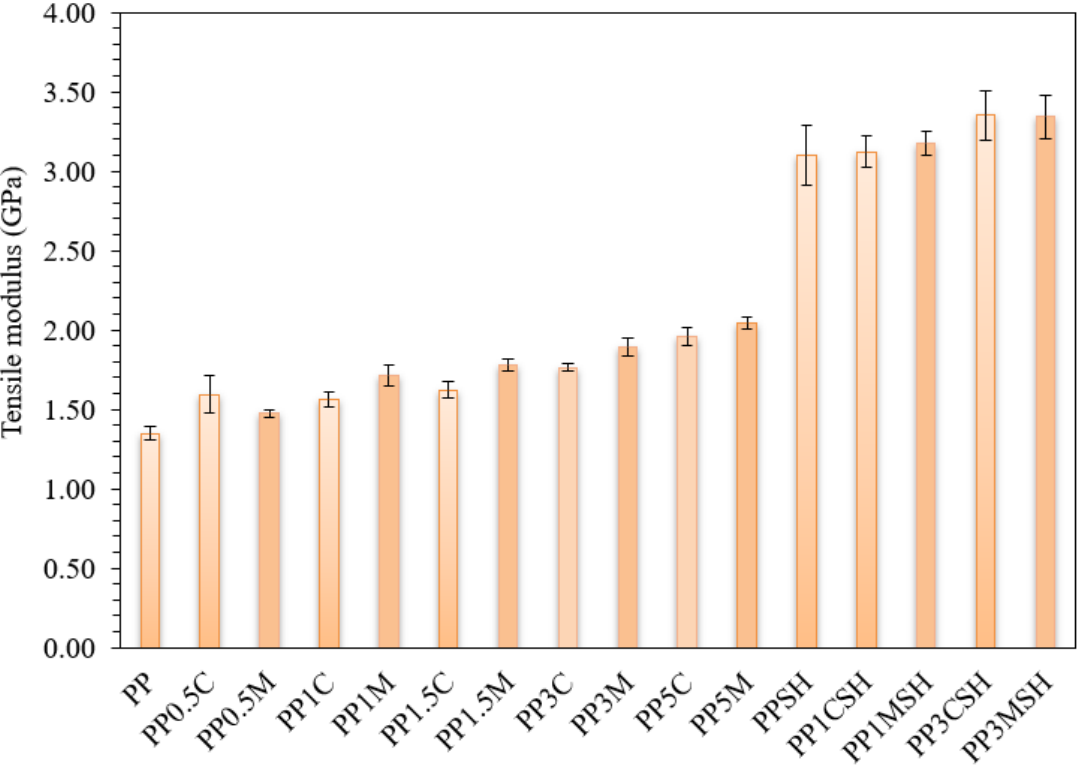
Figure 9. Tensile modulus of PP composites compared to neat PP; darker bars are related to the masterbatch-containing systems.